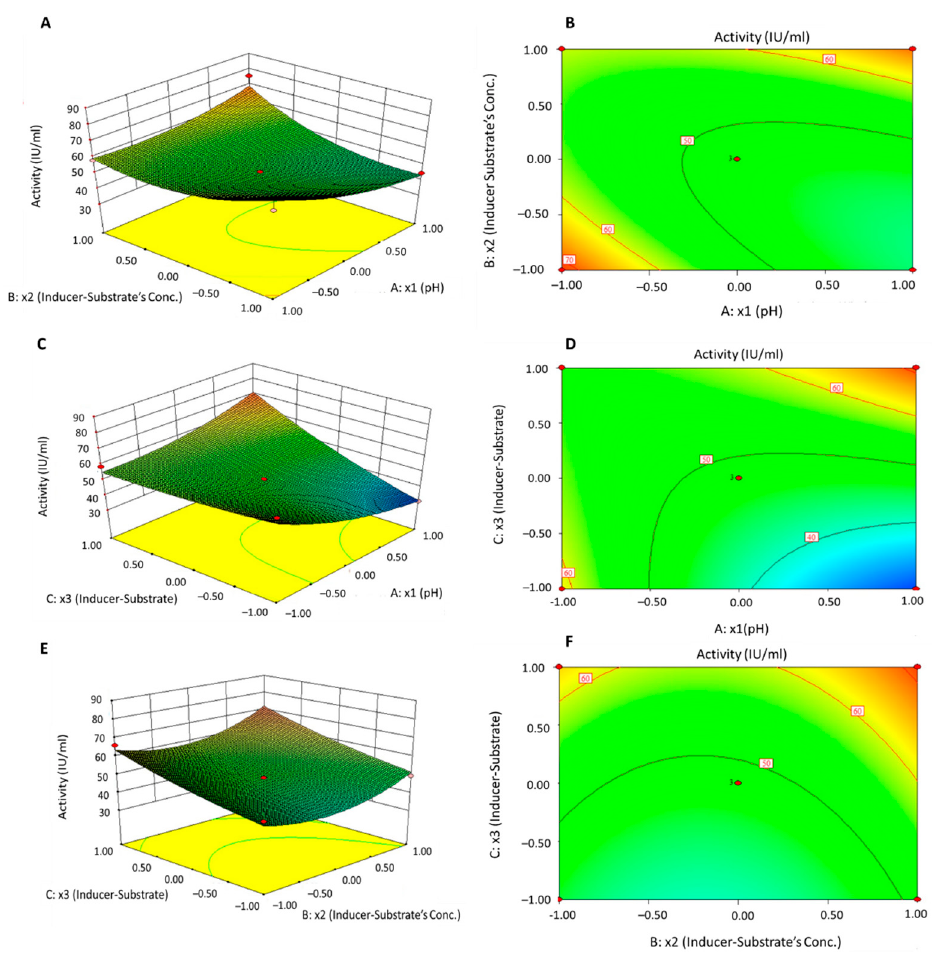
Figure 8. Response surface graph of EndoPGase activity of the isolated bacterial strain B. subtilis with respect to different experimental factors. ( A , B ) pH (4, 5, 6) vs. inducer-substrate’s concentration (1%, 4%, 6%); ( C , D ) pH vs. inducer-substrate (wheat bran, corn starch, and citrus peel); ( E , F ) inducer-substrate’s concentration vs. inducer-substrate, respectively. Table 1. Analysis of variance [ANOVA] table [Partial sum of squares—Type III] for response surface quadratic model.